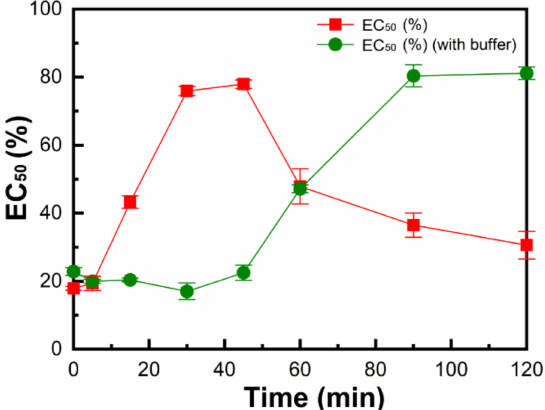
Figure 8. EC 50 of MnO 2 /UV/PS process mixtures determined after four-fold dilution with the Microtox ® Basic test. Initial conditions: [BPA] = 30 mg/L, [PS] = 1 mM, [MnO 2 ] = 0.25 g/L, with (out) phosphate buffer, pH =